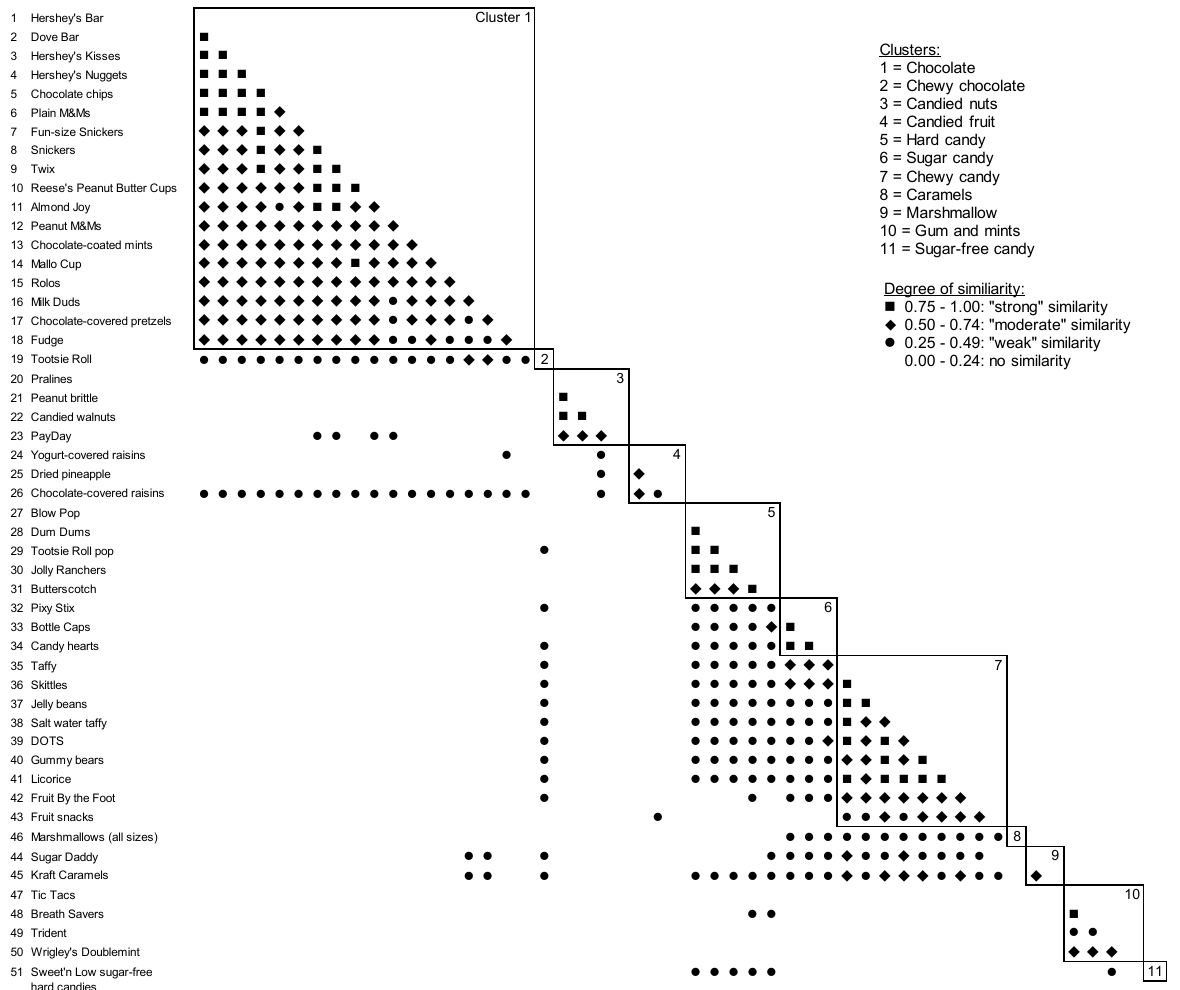
Figure 1. Similarity matrix of parent’s card sort of 51 candy items into piles ( n = 35).